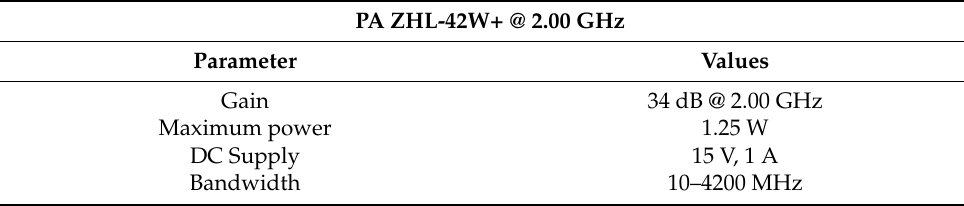
Table 2. Features of the ZHL-42W+ PA at 32.24 dBm.